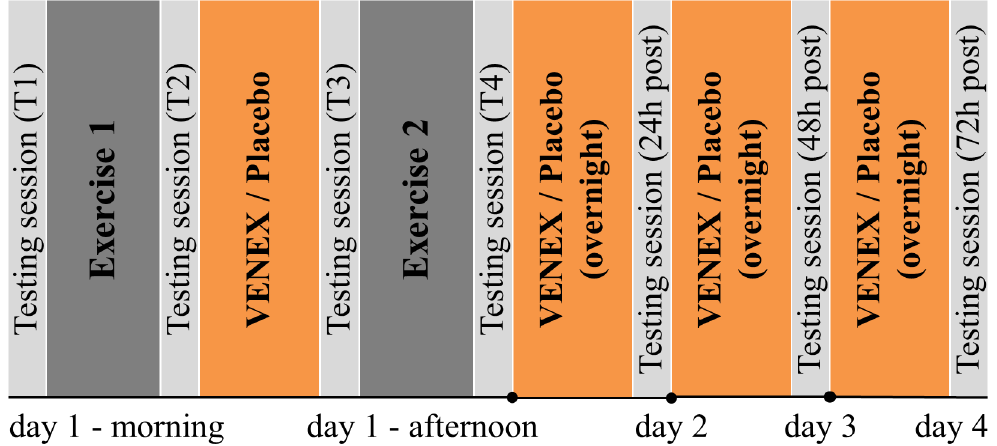
Fig 1. Study protocol. The testing and exercise procedureconsisted of 7 testing sessions and two exercise session. Day 1 started with baselinetesting (T1) prior to the first exercise, which was followedby the second testing (T2). After T2 subjectshad to rest for three hours wearingVenex or Placeboduringthe first hour of rest. Afterwards, the third testing (T3) was performed just before the second exercise and a subsequent fourth testing (T4). Followingthe exercise day, participantshad to wear either Venex or placeboovernight.Testing sessions 5, 6, and 7 took place 24h, 48h and 72 hours after T1. This protocol was executed twice in a single-blinded cross-over designso that every participantrun through the process once with the Venex wear and once with the placebo